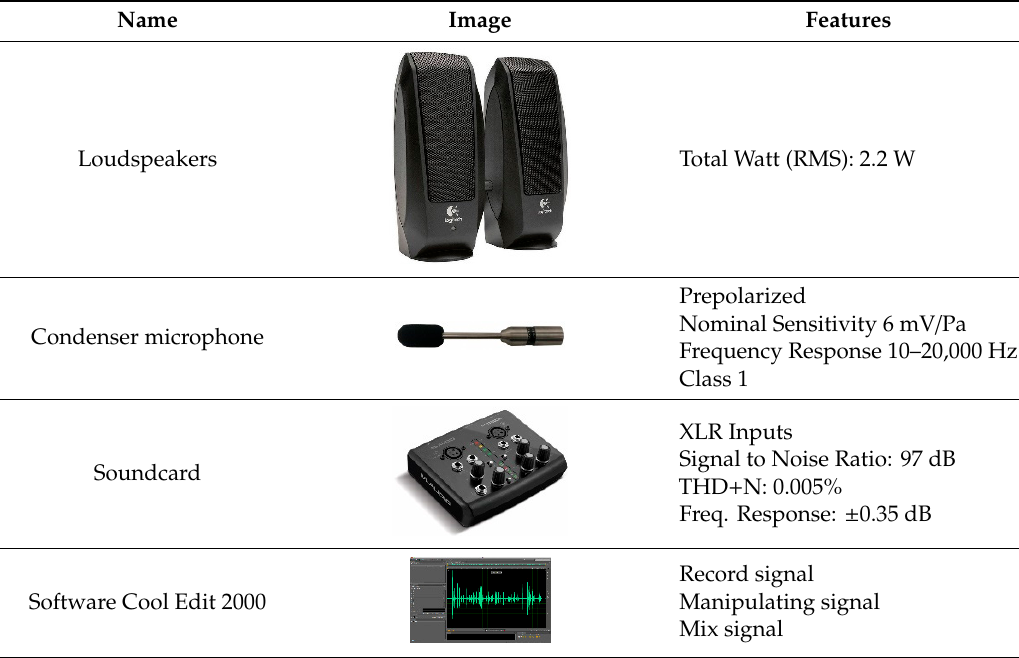
Table 2. Material used in acoustic measurements ( IL ).